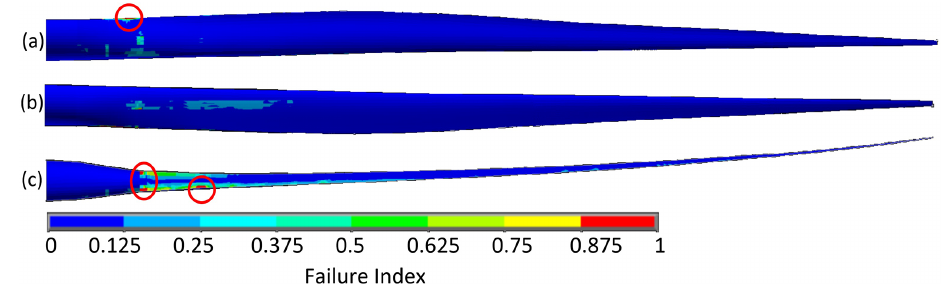
Figure 10. Tsai–Wu failure index for the optimized BAR-URC design under critical loading, shown from the (a) pressure side, (b) suction side, and (c) cut-away view, showing the leading shear web. Vulnerable areas circled in red.